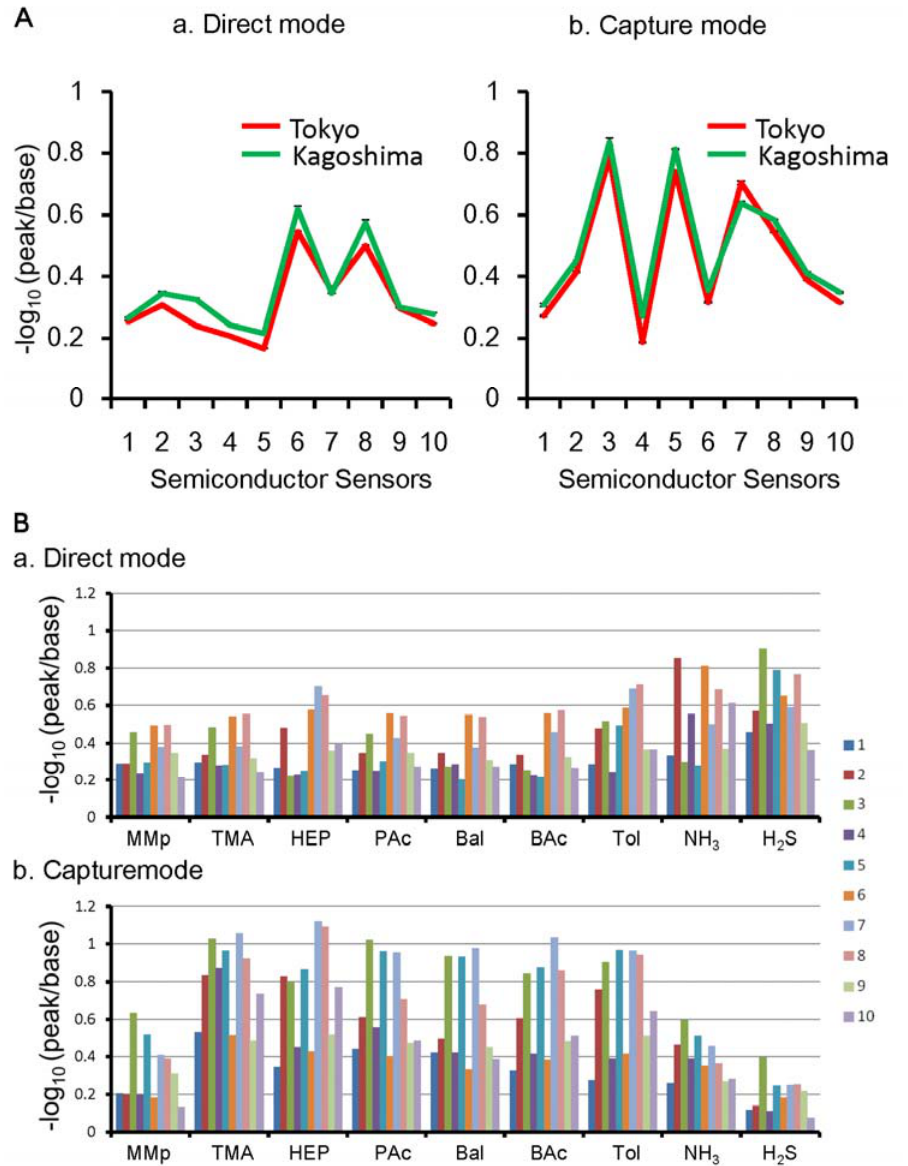
Figure 2. Measured values of odor samples. ( A ) inflorescences of titan arum plants at the 2 locations. To take into account the effect of humidity, measurements were conducted using the direct mode (a) and the capture mode (b); ( B ) Different response patterns of 10 semiconductors for each standard gas at one concentration. (a) direct mode; (b) capture mode. MMp; Methyl mercaptan (1 ppm), TMA; trimethylamine (1 ppm); HEP; heptane (3 ppm), Pac; propionic acid (2 ppm), BAL; butyl aldehyde (1 ppm), BAC; butyl acetate (1 ppm), Tol; toluene (3 ppm), NH ; ammonia (30 ppm), H S; hydrogen sulfide (10 ppm). 3 2